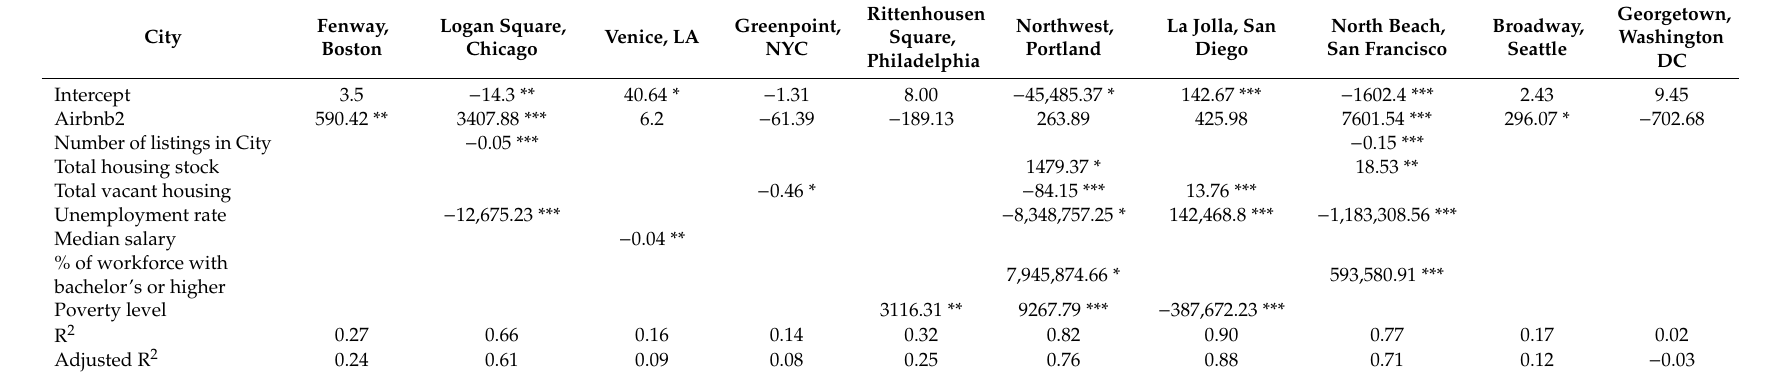
Table 7. Results using Airbnb density as a proportion of the vacant supply of